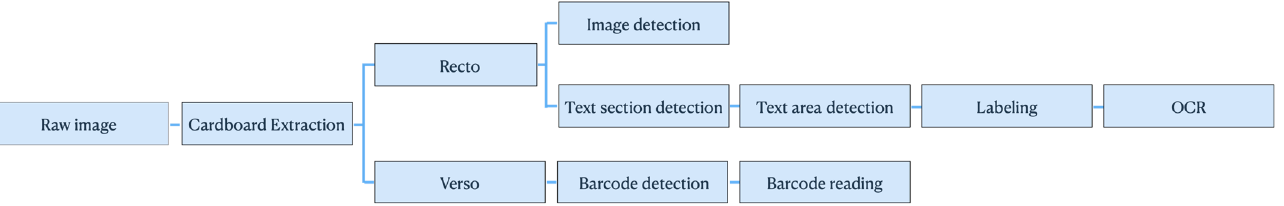
Figure 6. Schema of Recto and Verso Extraction Processing . This is in fact the key information: the address of the item that makes it possible, in the topographical vastness of an archive, to find it and to validate the equivalence between the scanned image and its material consistency [10]. Cardboards are physically placed in drawers. It was therefore decided to assign a barcode that identified the archival position relative to the drawer and the position of the cardboard inside the drawer. In this way, through the automatic reading of the barcode with the scanner software, a json file was generated containing the archival position data associated with the scanned image. The various operators were able to move forward quickly by applying barcodes on the verso of items, only having to verify the exact correspondence between the item, the archival location and the generated code (Figure 7). Figure 7. Schema of Cardboard Verso - Barcode Detection .